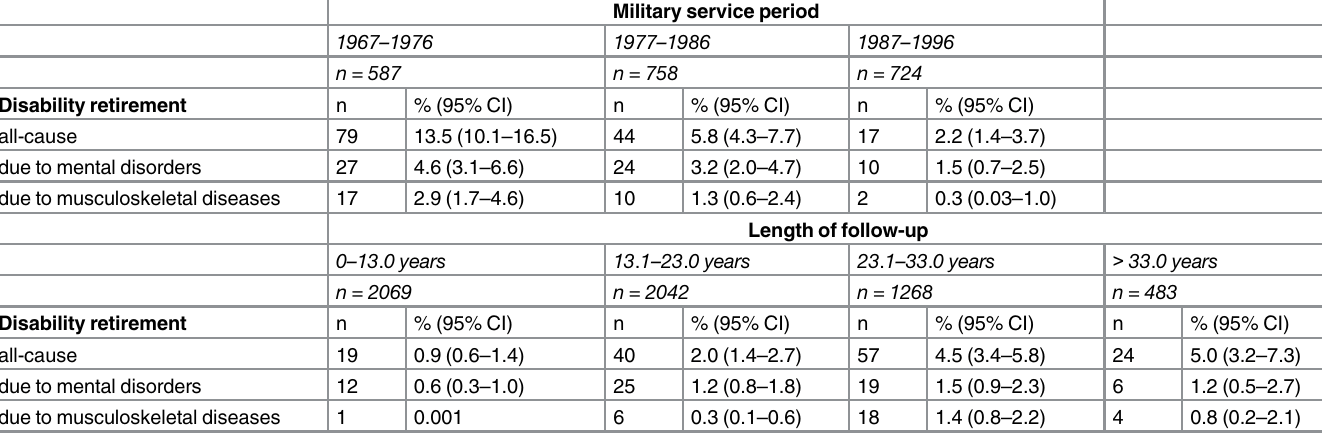
Table 2. Cumulative incidence (%) of disability retirement in the study group by the military service period and the length of